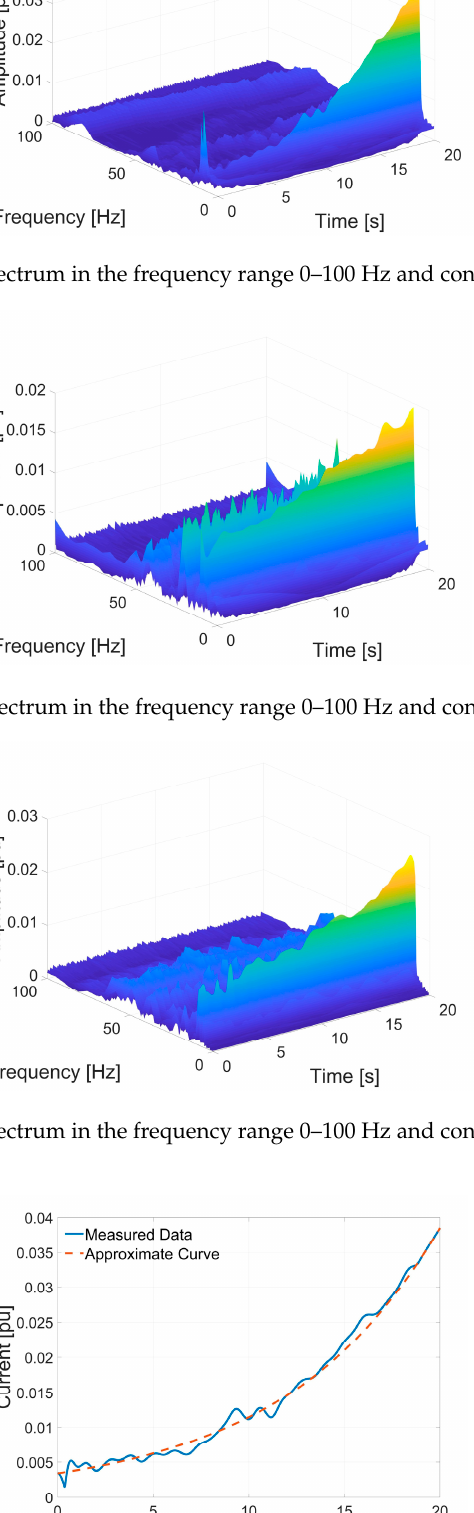
i ′ spectrum in the frequency Figure 12. DC range (0–100) Hz and configuration CD.